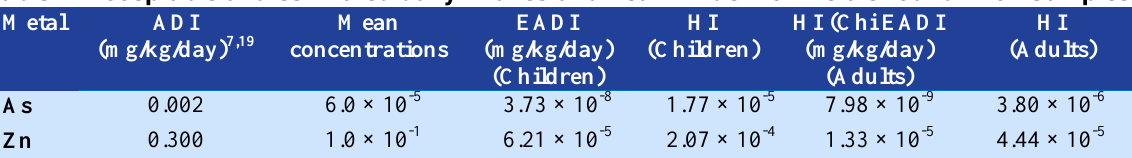
Table 2. Acceptable and estimated daily intakes and health index for metals found in oil